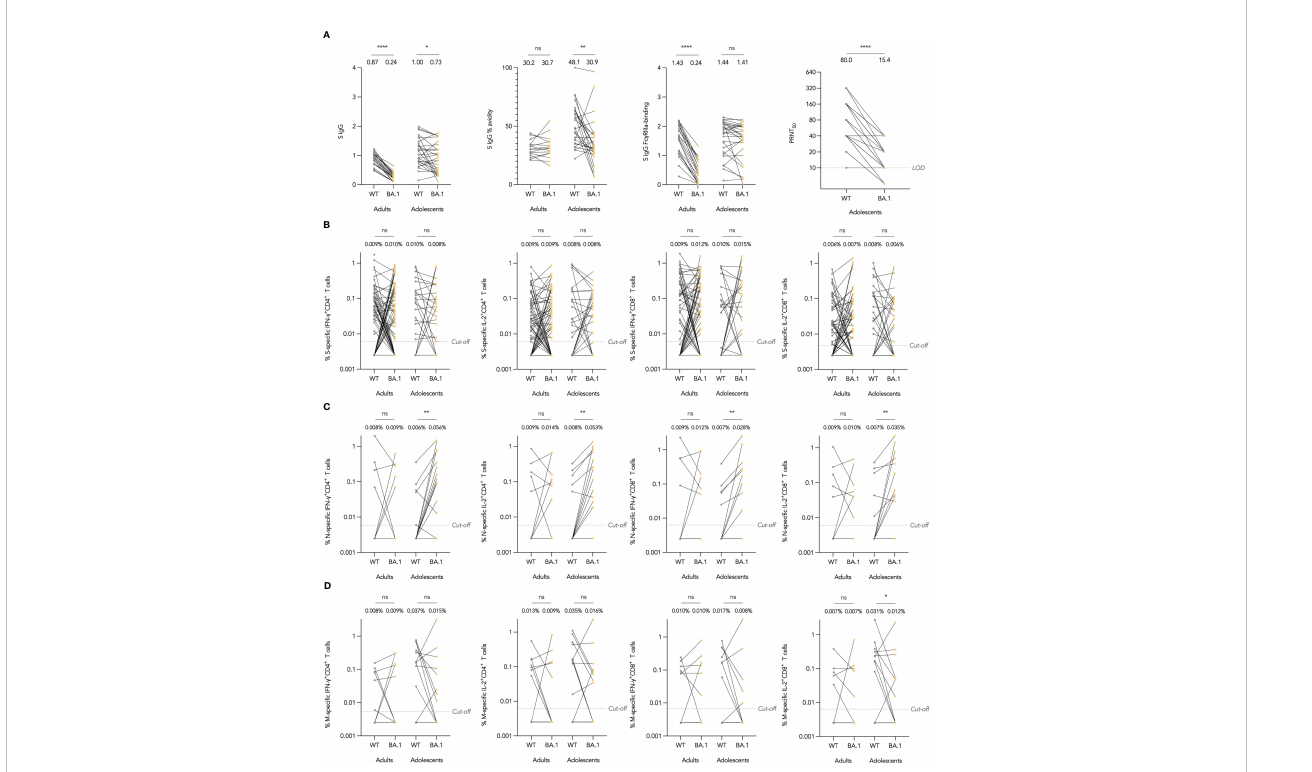
FIGURE 3 Omicron BA.1-speci fi c humoral and cellular immunogenicity after the third dose of CoronaVac in healthy evaluable adolescents and adults. (A) Wild- type (WT) and BA.1 SARS-CoV-2 Spike (S) IgG OD450 values, S IgG avidity index, and S IgG Fc g receptor IIIa (Fc g RIIIa)-binding OD450 values, and 50% plaque reduction neutralization titers (PRNT). (B-D) Separate S, N and Membrane (M) protein WT reference pool and BA.1 mutation pool- speci fi c interferon- g (IFN- g )+ and interleukin-2 (IL-2)+ CD4+ and CD8+ T cell frequencies. Samples from the same participant were paired between WT and BA.1 and compared with paired t test after natural logarithmic transformation with p-values denoted (*, P<0.05; **, P<0.01; ****, P<0.0001; ns, not signi fi